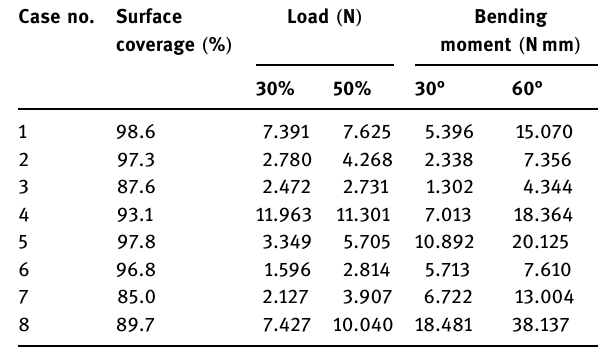
Table 4: Surface coverage, compression load, and bending